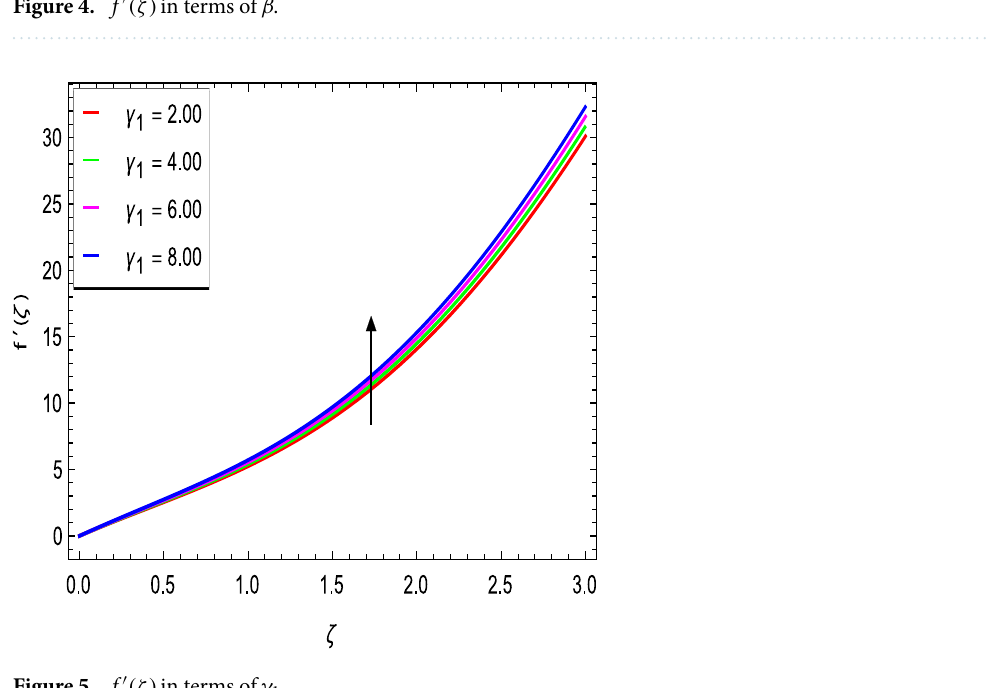
Figure 5. f ′ (ζ) in terms of γ 1